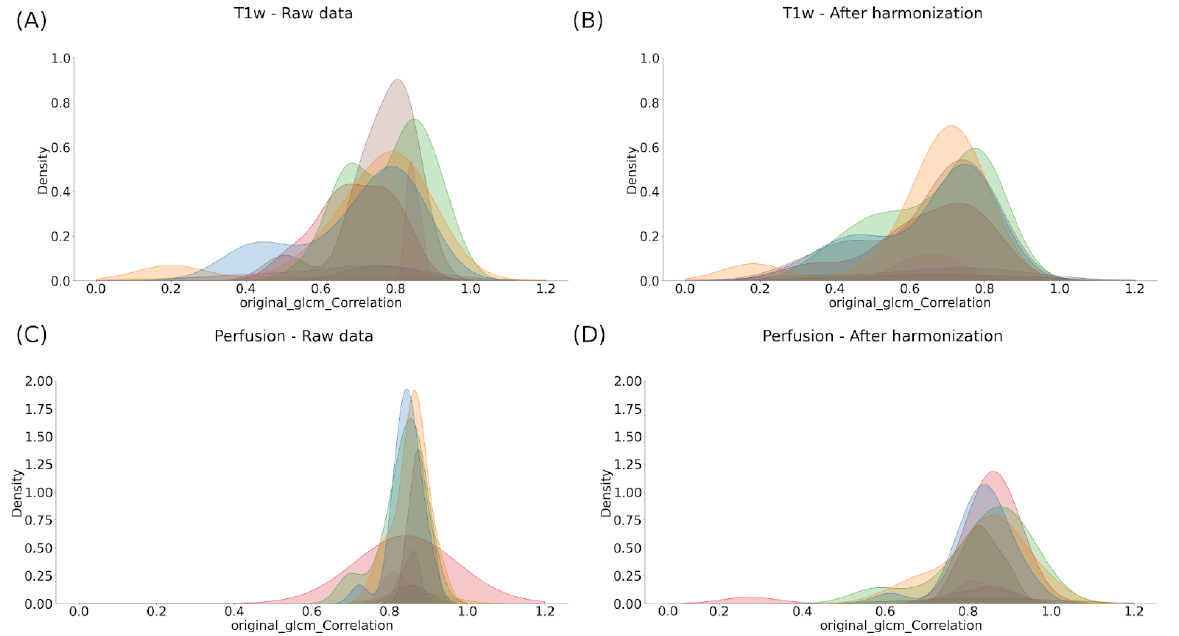
Figure 3. Effect of harmonization on the distribution of an example radiomic feature extracted from the healthy ROIs across the different scanners (namely, glcm-Correlation) before ( A , C ) and after ComBat harmonization ( B , D ).